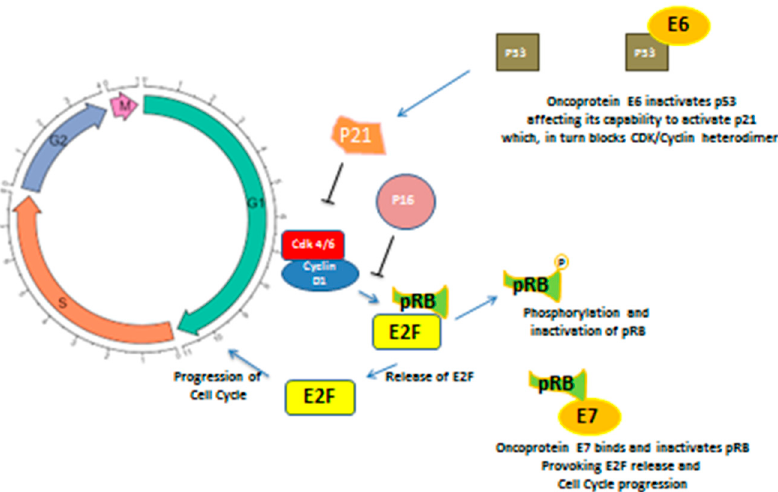
Figure 1. Oncoproteins E6 and E7 induce cell cycle progression acting upon cell cycle regulation, in particular during G1/S transition. E6 binds and inactivates P53, affecting its capability to activate P21, which in turn is not able to arrest CyclinD1/Cdk4/6 heterodimer. Oncoprotein E7 directly acts on RB, linking and inactivating it, leading to E2F upregulation and cell cycle progression.E2F: elongation factor 2; pRB: retinoblastoma protein; Cdk4/6: cyclin dependent kinase; p21: protein 21; E6: oncoprotein 6; E7: oncoprotein 7.